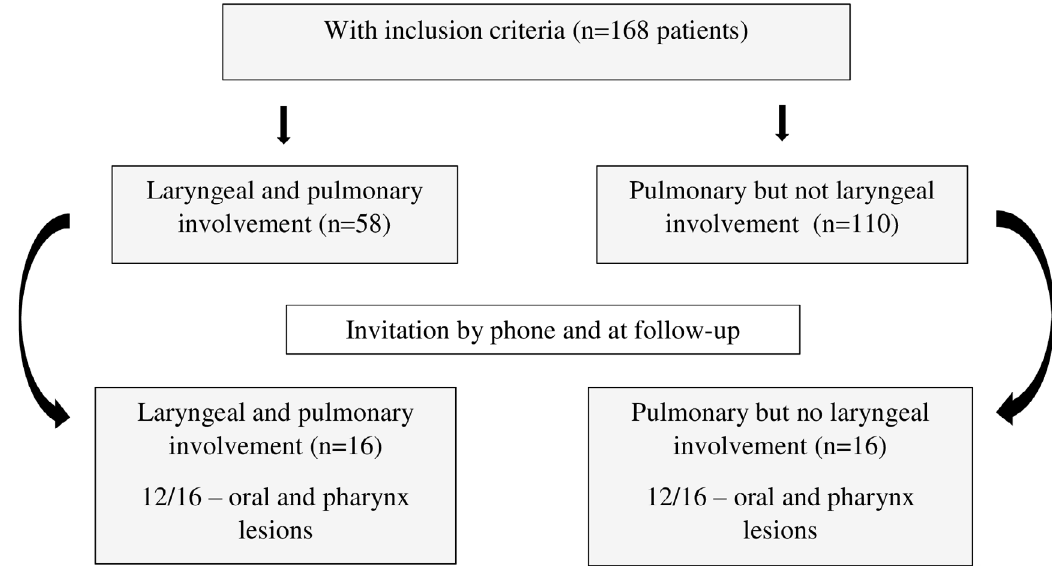
Figure 1. Flowchart of paracoccidioidomycosis patients evaluated regarding voice- and swallowing-related quality of